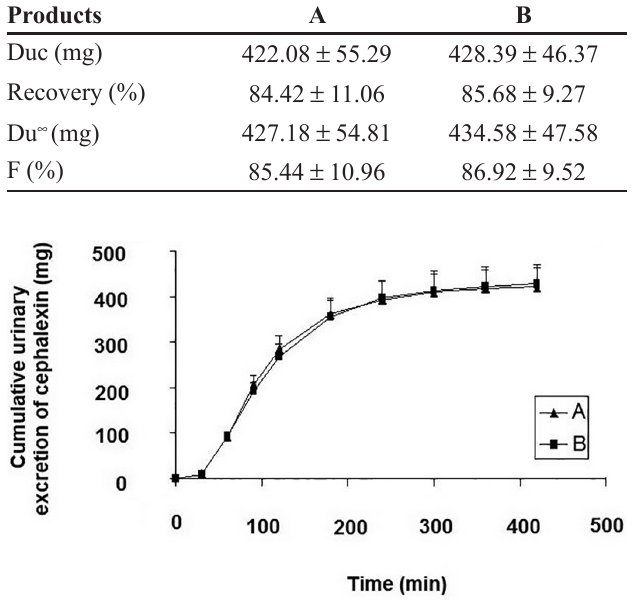
FIGURE 3 - Mean of cumulative amount of cephalexin excreted in urine ( Duc ) followed by oral administration of immediate- release tablets (A and B products, n=24). Bars indicate standard